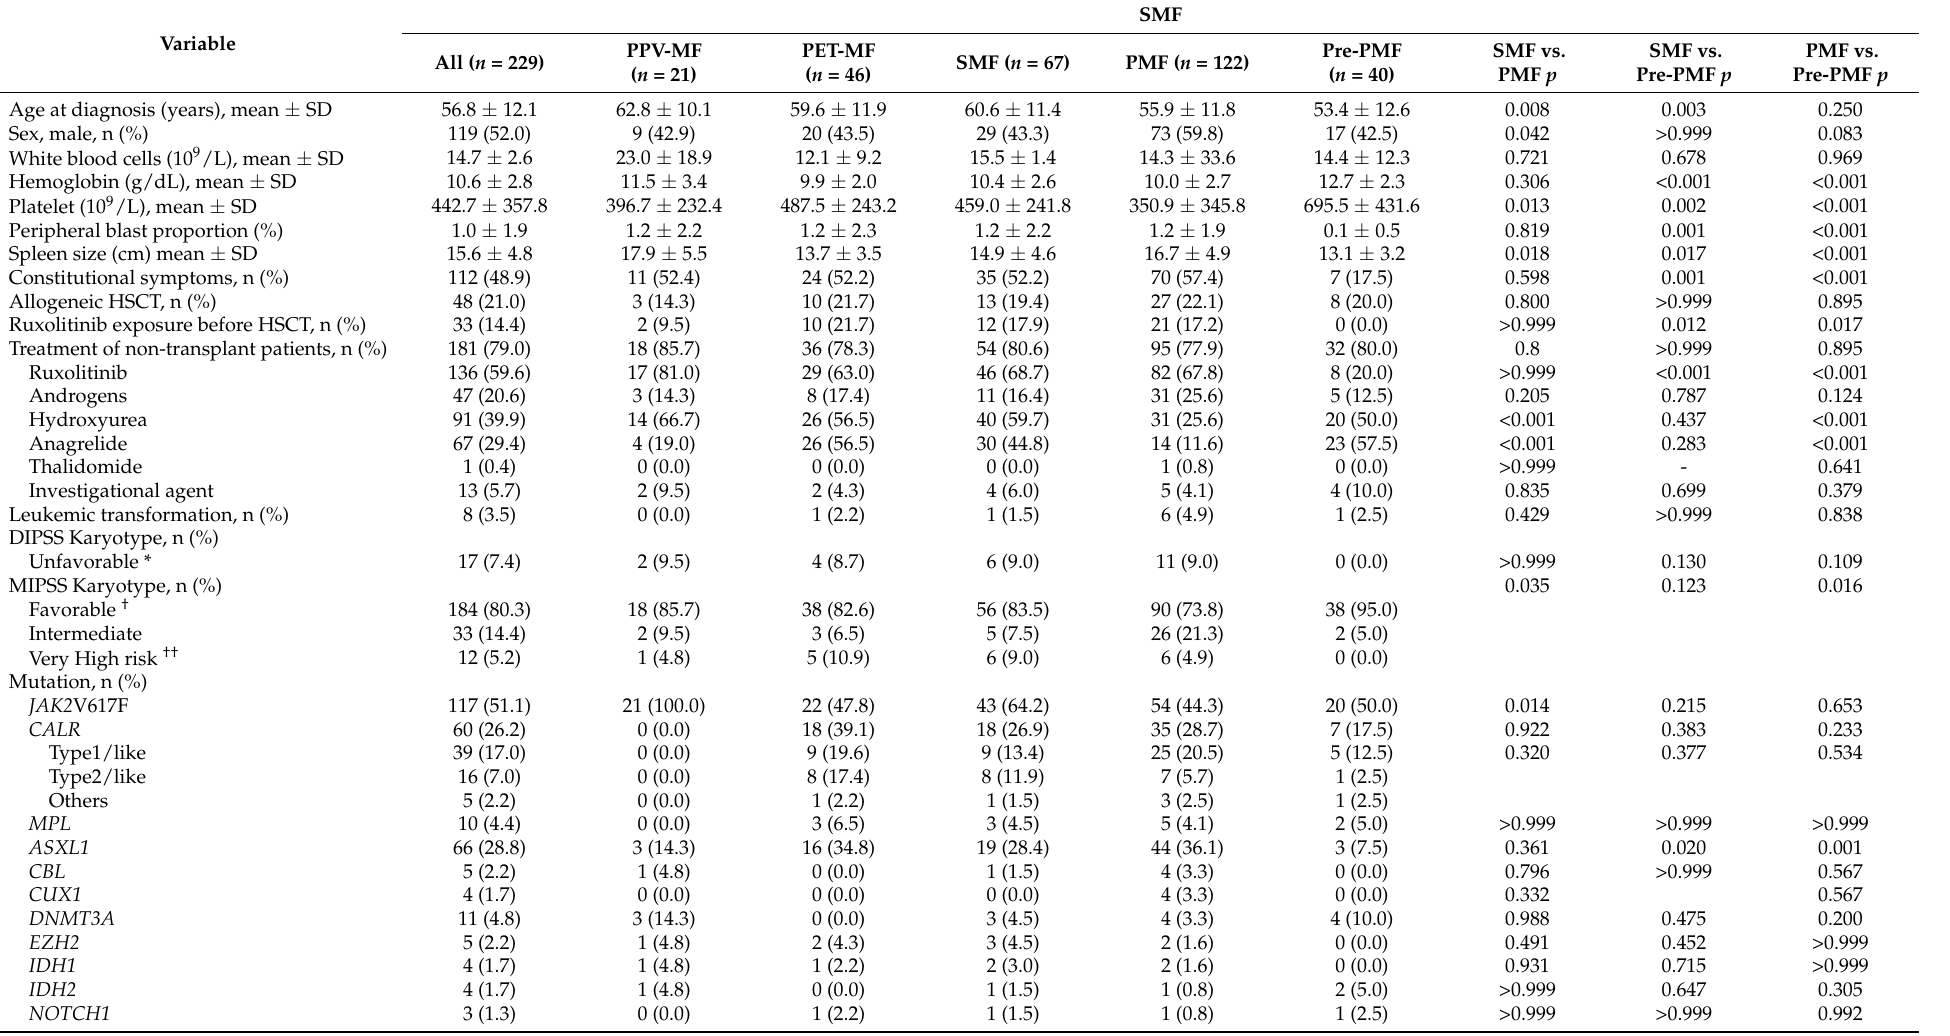
Table 1. Baseline clinical and genetic characteristics of patients in the present